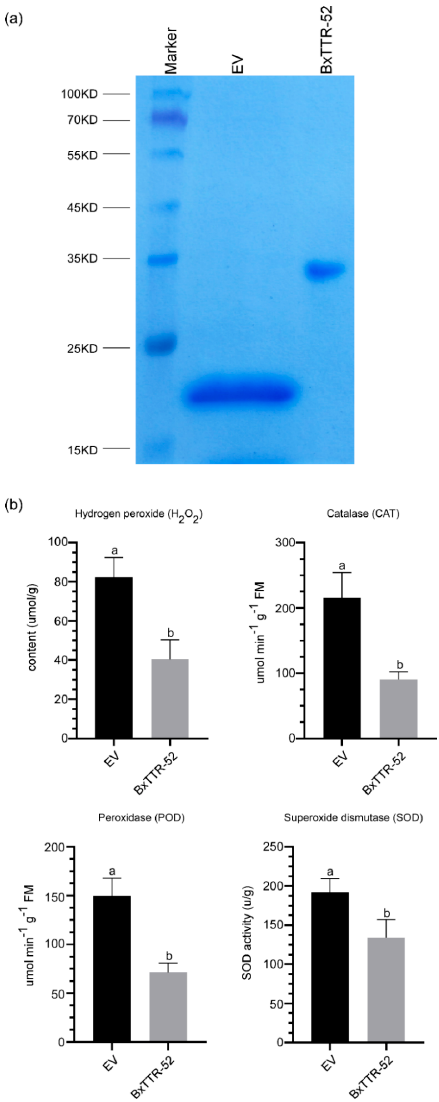
Figure 3. BxTTR-52 suppressed the accumulation of ROS and antioxidant enzymes. ( a ) SDS-polyacrylamide gel electrophoresis (SDS-PAGE) verification of the BxTTR-52 protein. ( b ) The content of ROS and antioxidant enzymes. Values represent the means ± SD of three independent biological samples. Different letters on top of the bars indicate statistically significant differences ( p < 0.05, t -test) as measured by Duncan’s multiple range